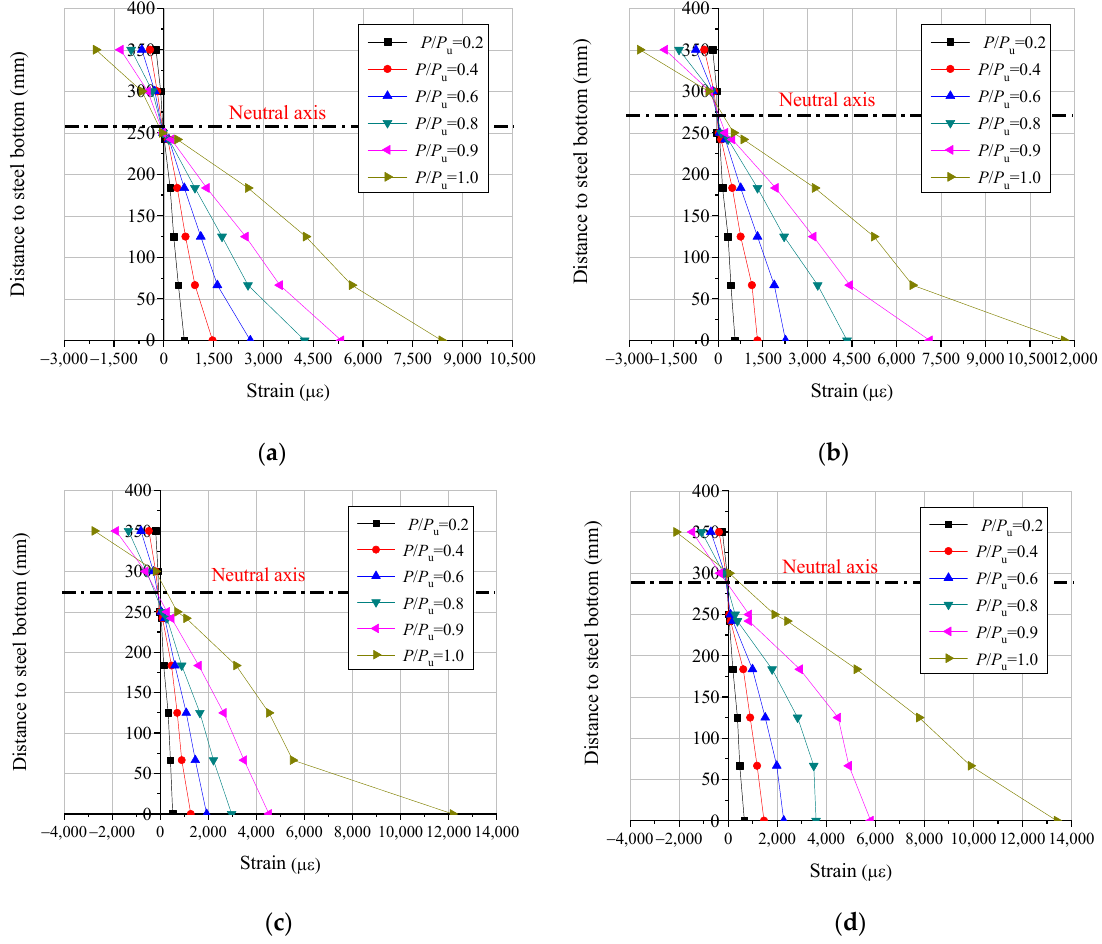
Figure 6. Strain profile of composite cross-section, ( a ) specimen HSB1, ( b ) specimen HSB2, ( c ) specimen HSCB1, and ( d ) specimen HSCB2.